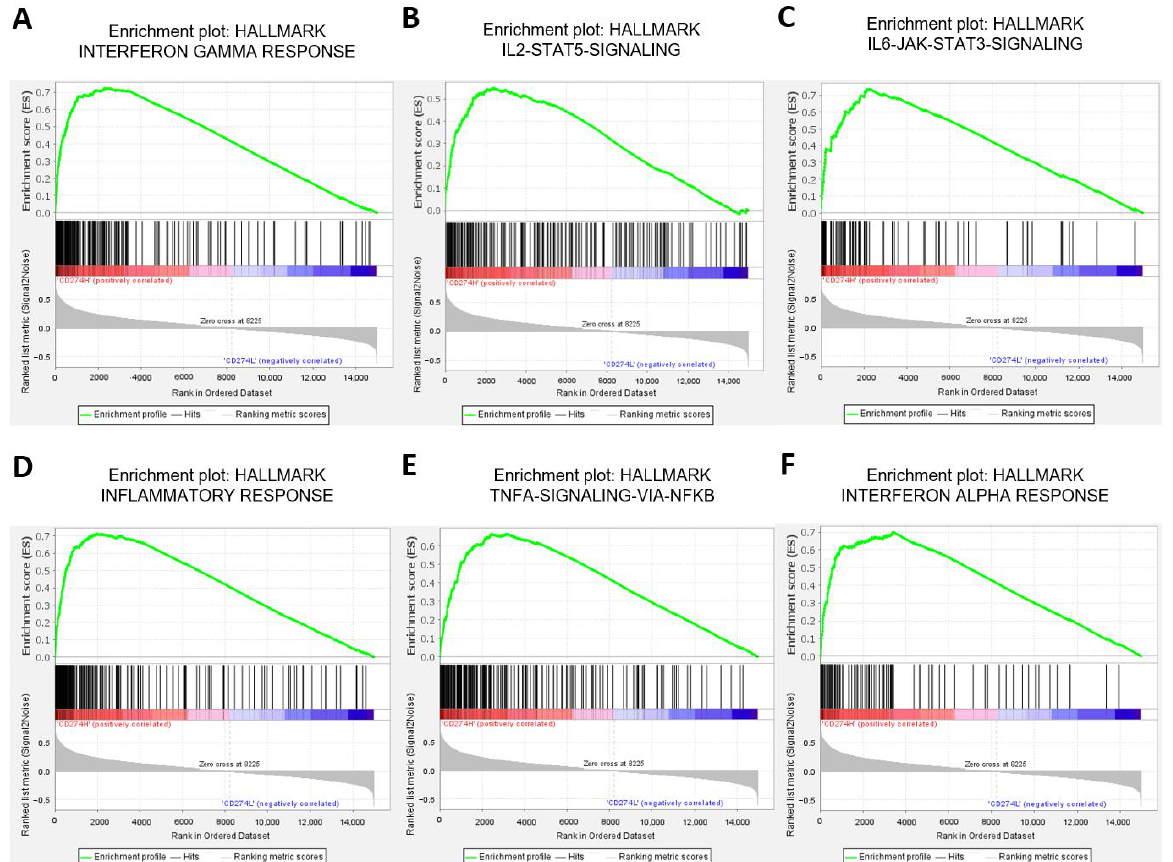
Figure 3. Gene set enrichment analysis in CRCs with high and low CD274 expression. Hallmark gene sets were applied for gene set enrichment analysis in two phenotypes: CRCs with high and low CD274 expression according to the medial expression level of CD274 . The colored band at the bottom represents the degree of correlation of the expression of these genes (red for a positive correlation and blue for a negative correlation) in each gene signature. The immune-related gene sets enriched in CRCs with high CD274 expression are shown, including ( A ) the IFN-gamma response, ( B ) IL-2-STAT5- signaling, ( C ) IL-6-JAK-STAT-signaling, ( D ) the inflammatory response, ( E ) TNFA-signaling-vial NFKB, and ( F ) the IFN-alpha response. IFN, interferon; TNFA, tumor necrosis factor-alpha; NFKB, nuclear factor